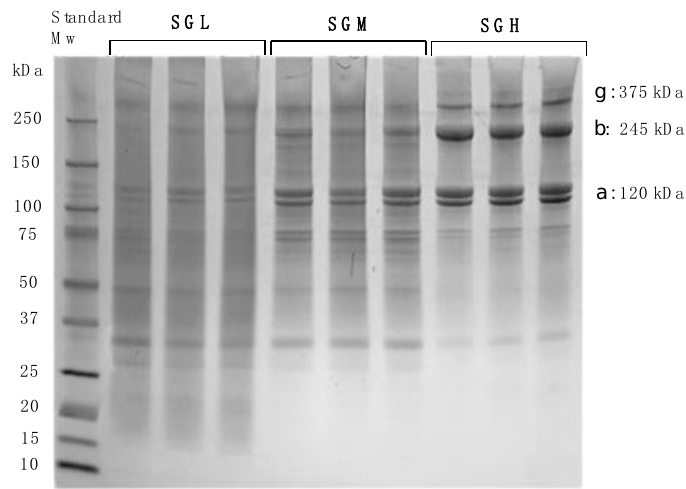
Figure 1. SDS-PAGE electrophoresis of SG samples; SGL, SGM, and SGH with controlled molecular weight.